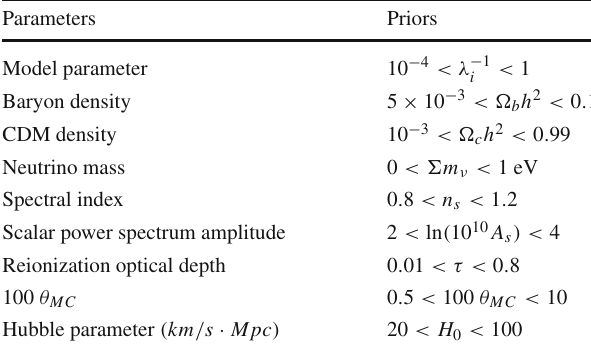
Table 1 List of the prior for the cosmological parameters, where θ MC is the sound horizon to the angular diameter distance, and A s is the primordial superhorizon power in the curvature perturbation on 0.05 Mpc − 1 scales